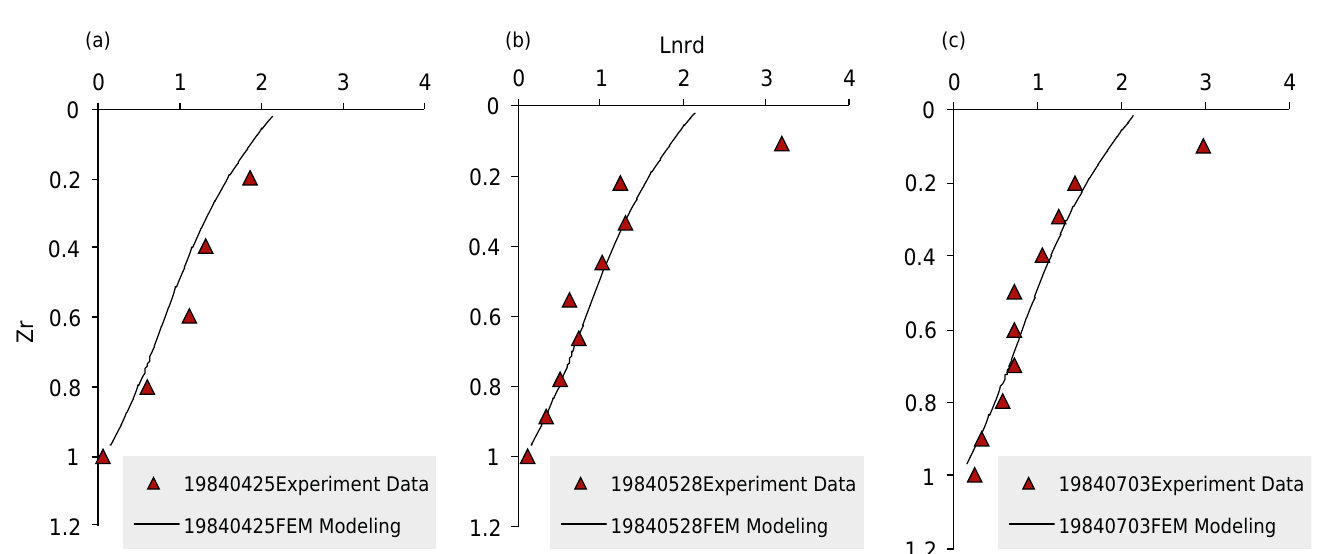
Table 4. Statistical index values of performance of the model